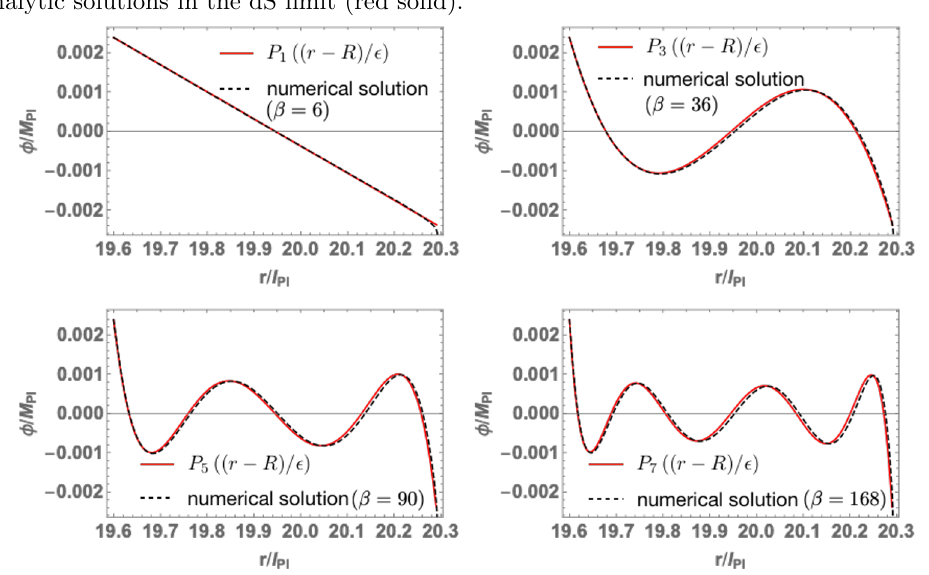
Figure 6 . Comparison between the numerically obtined oscillating bounce solutions (black dashed) and analytic solutions in the dS limit (red solid).